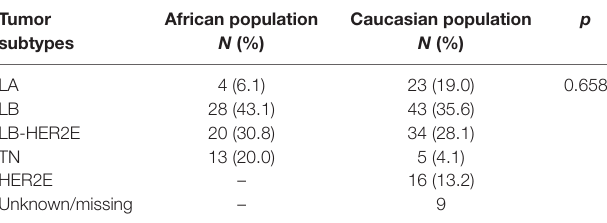
TaBle 2 | Distribution of tumor subtypes in African and Caucasian populations.